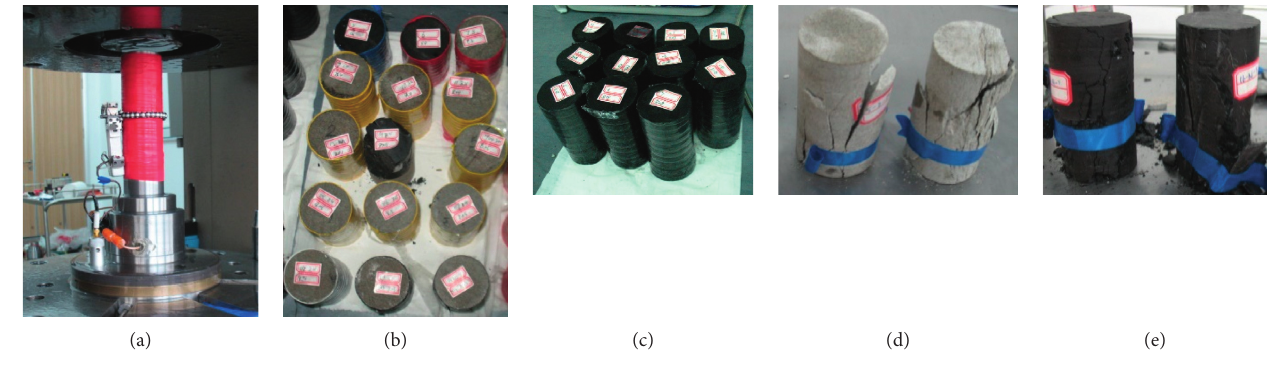
Figure 3: Testing apparatus and rock samples after testing. Table 2: Results of conventional triaxial compression tests. Lithology